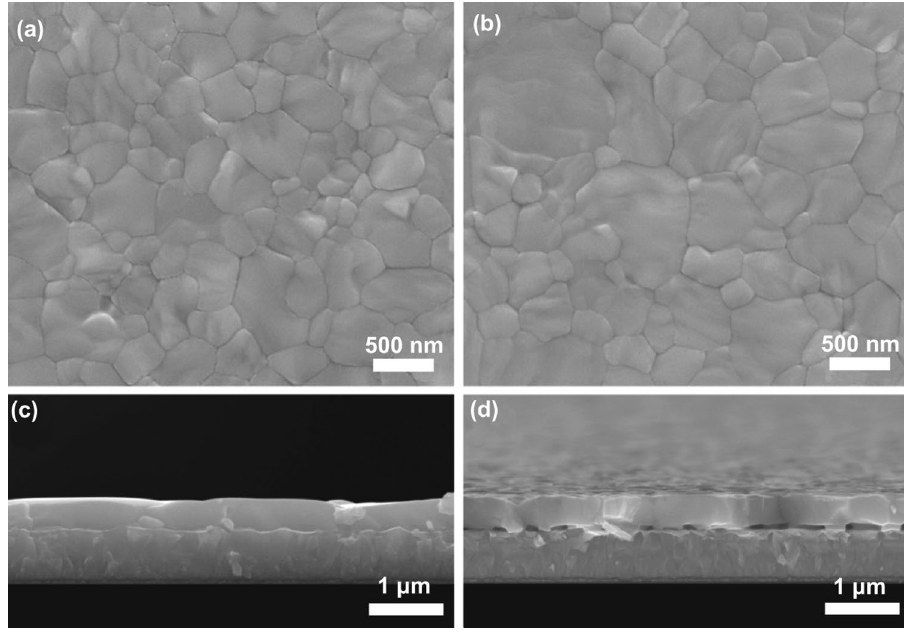
Fig. 2 Top-view and cross-sectional SEM images of CsPbIBr 2 films deposited on FTO/TiO 2 substrates: a , c without and b , d with loading of PEAI